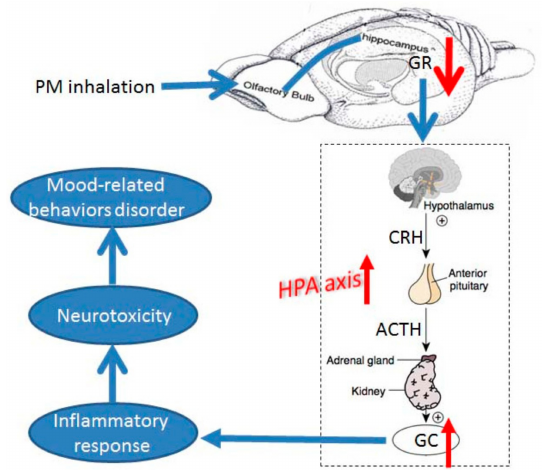
Figure 6. Mechanistic framework explaining how inhaled air pollutants disrupt mood related behavior. After PM 2.5 exposure, the decreased expression level of GR in hippocampus result in the increased secreting of glucocorticoid, which activated inflammatory response of hippocampus, and thus provoked the mood-related behaviors disorder. PM: particulate matter; GR: glucocorticoid receptors; GC: glucocorticoid; HPA: hypothalamic-pituitary-adrenal; CRH: corticotropin-releasing hormone; ACTH: adrenocorticotropic